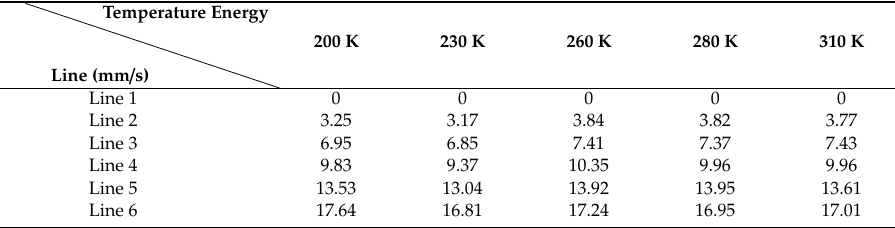
Table 2. The energy transition lines converted by PBCs at di ff erent